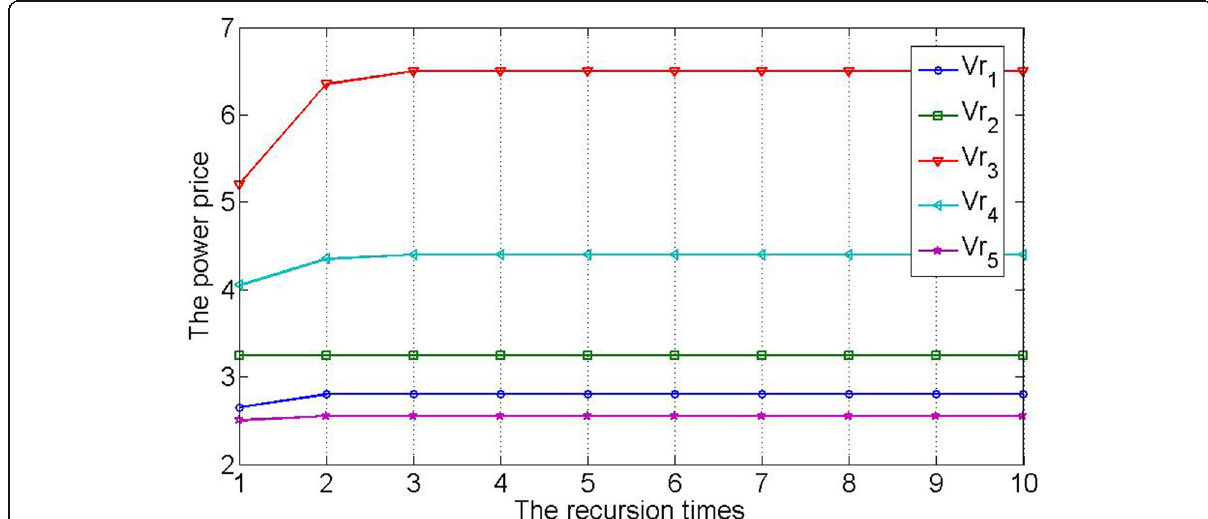
Fig. 4 The power price of the cooperative relay nodes gradually converge with the recursion